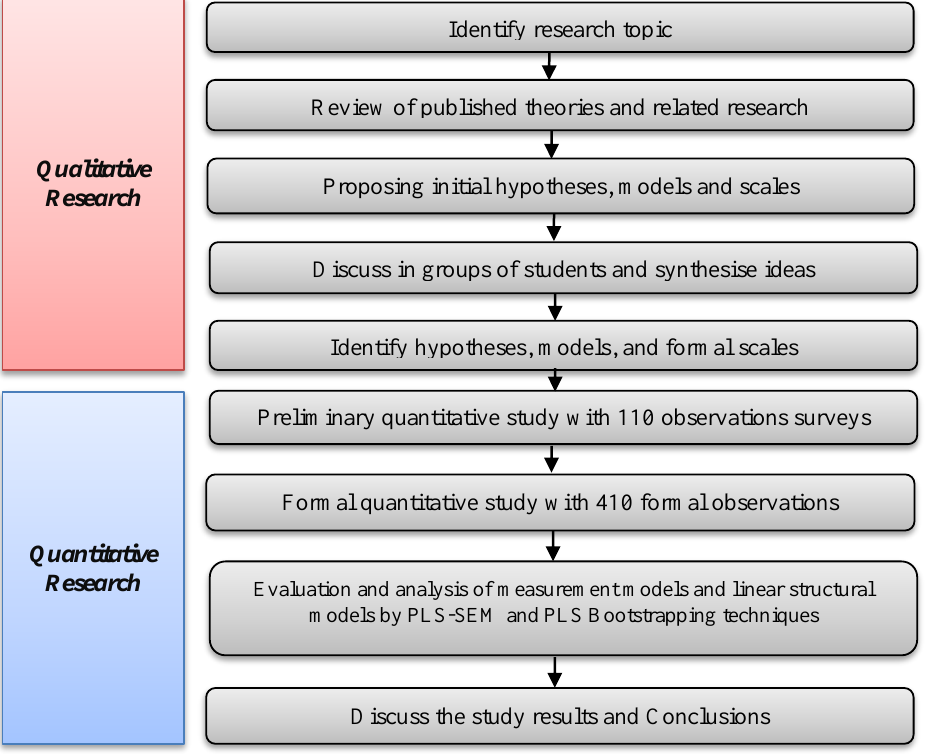
Figure 3. Overview of the research process and